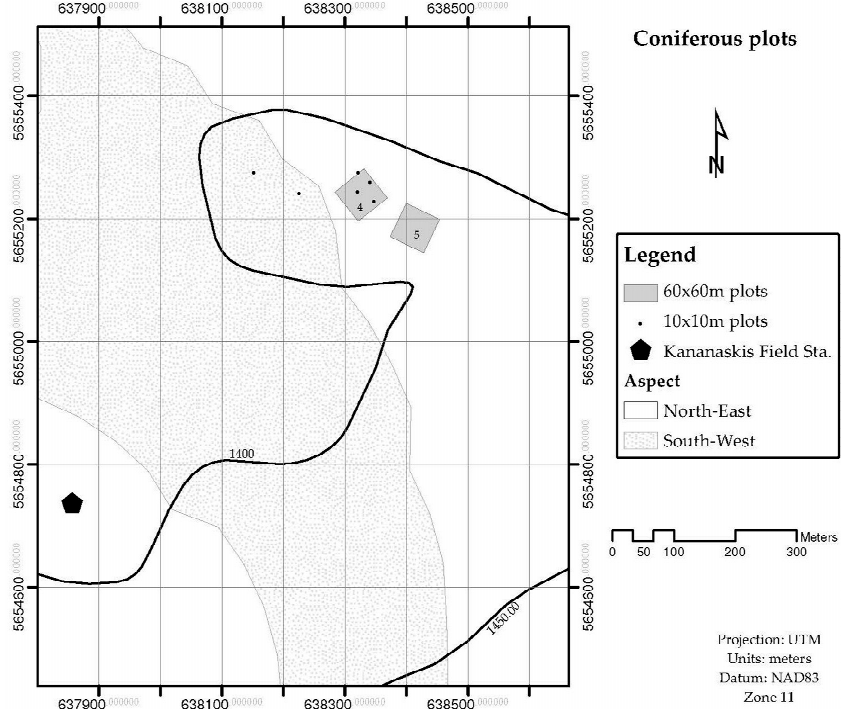
Forests 2019 , 10 , 829 Figure 1. Geographical location of coniferous plots. The plots are in the Sibbald area, Kananaskis Country.